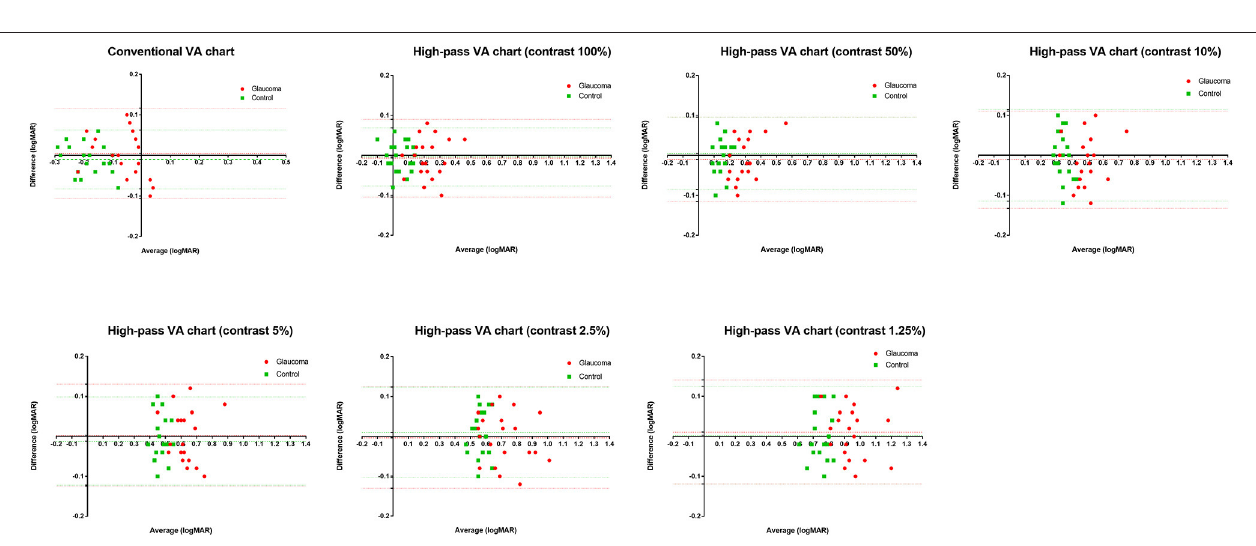
FIGURE 3 | Bland-Altman plots for test-retest measurements for the conventional chart (1st test vs. 2nd test) and the high-pass charts (1st test vs. 2nd test) with data for the 20 healthy controls plotted in green (squares) and the 20 glaucoma patients in red (dots). The mean difference of the two tests and 95% Limits of Agreements are also shown in the plots (dotted